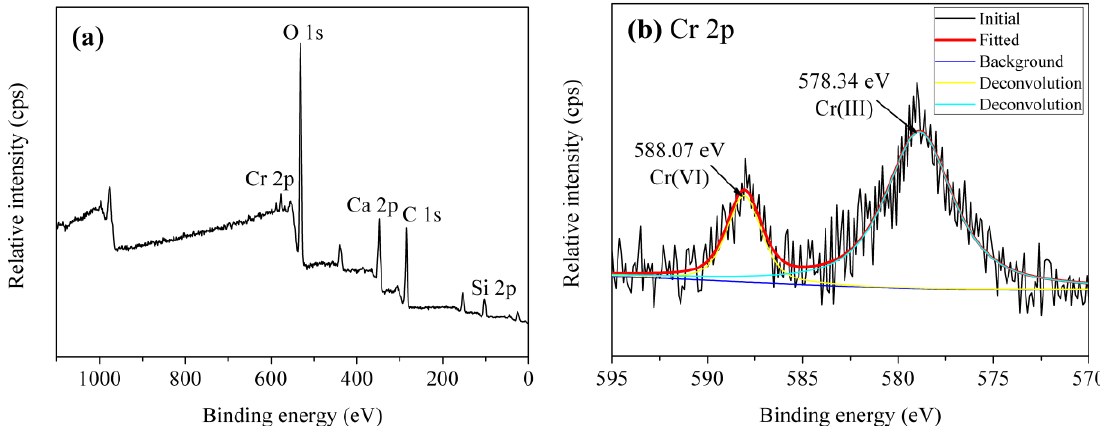
Figure 12. XPS spectra of the tobermorite sample after absorption: ( a ) survey; and ( b ) Cr 2p.